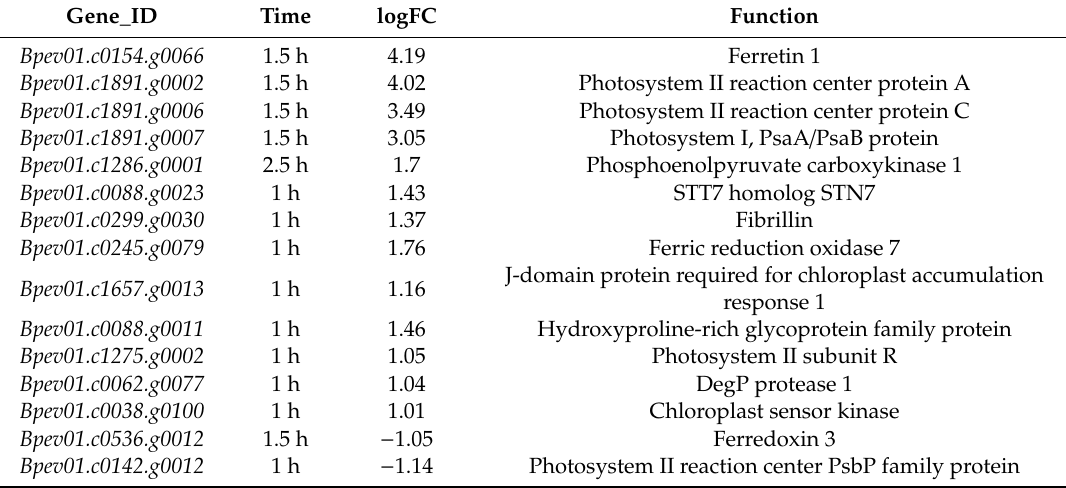
Table A9. Photosynthesis-related DEGs under low-temperature stress in